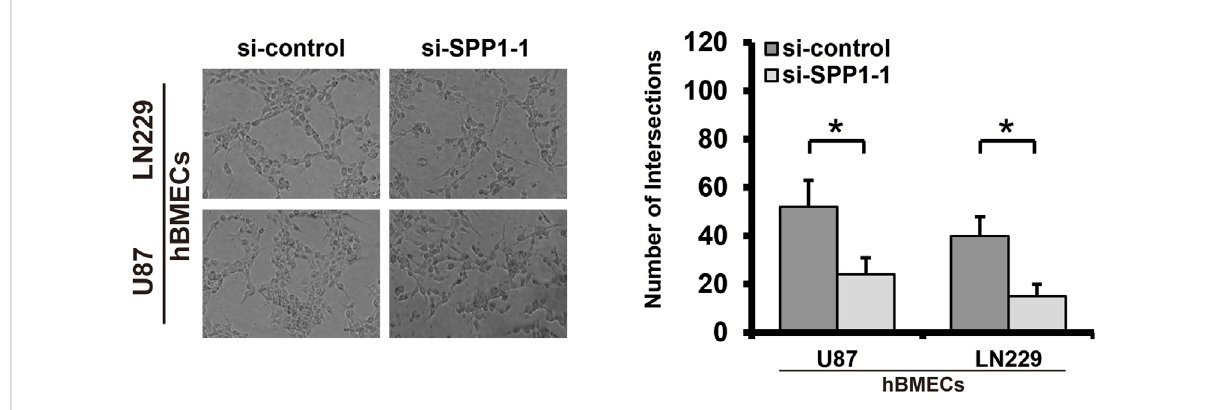
FIGURE 13 Tube formation assay. Knockdown of SPP1 inhibited tumor angiogenesis in vitro. All experiments were performed in